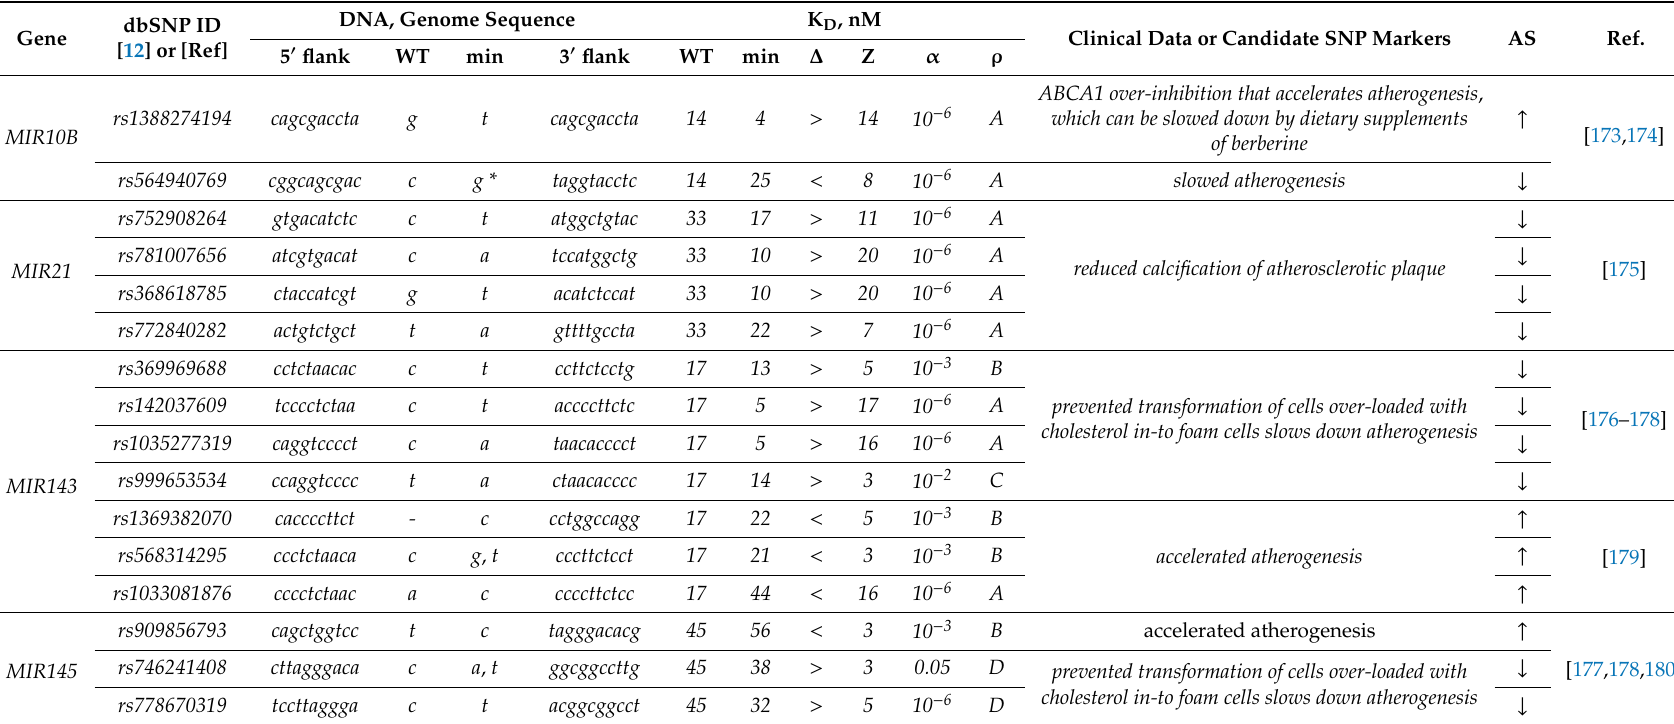
Table 9. Atherogenesis-related candidate SNP markers within the promoters of miRNA genes associated with instability of the atherosclerotic